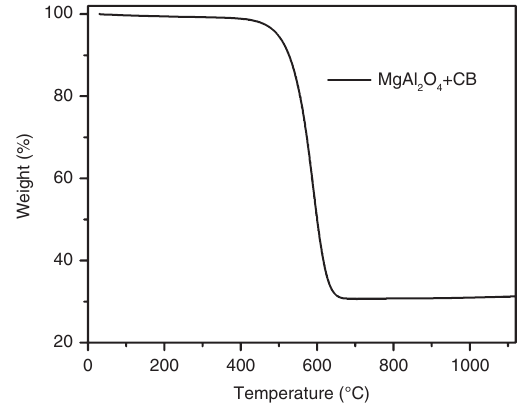
O and CB in 2 4